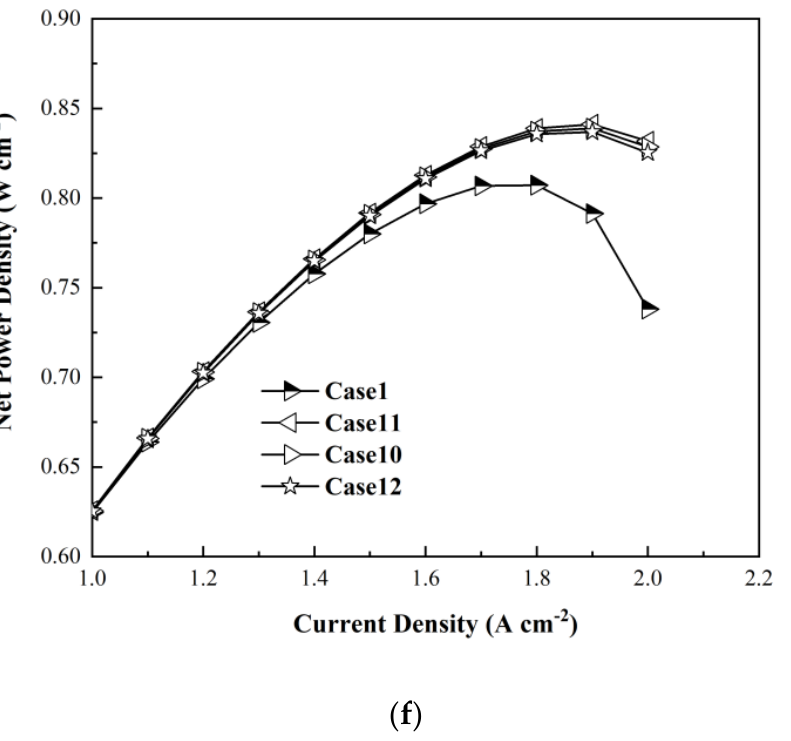
Figure 6. Performance of cases under different dimensionless lengths of the single baffle. ( a ) Polarization curves and gross power curves. ( b ) Partial enlarged polarization curves. ( c ) Average oxygen molar concentration between GDL and CL. ( d ) Contours of oxygen molar concentration at the current density set to 1.9 A · cm − 2 . ( e ) Contours of current density distribution at the current density set to 1.9 A · cm − 2 . ( f ) Net power density curves. Figure 6d,e show contours of oxygen molar concentration between GDL and CL and the current density distribution in the middle of the GDL of all cases at the current density set to 1.9 A · cm − 2 . Similar to the trend above, the smallest dimensionless length of the single baffle obtains the most even current density distribution, but the oxygen concentration difference among the cases is not obvious. Figure 6f shows the net power densities of cases with different length of the single baffle. Table 9 summarizes the influence of the dimensionless length of the single baffle on the power density at the current density set to 1.9 A · cm − 2 . Although pumping power decreases along the length of the single baffle, it can be seen that the net power density shows the same trend as gross power. However, the difference between different cases with different dimensionless lengths of the single baffle is not obvious. When the length of the single baffle is set to 3.6% of the channel, the PEMFC net power density could be increased by 6.29%, which is higher than a previous study [37]. Table 9. Cases performance under different dimensionless lengths of the single baffle. Case The ratio of the single baffle length to the channel length Pumping power density (W/cm 2 ) 0.0002 Percentage increase in net power